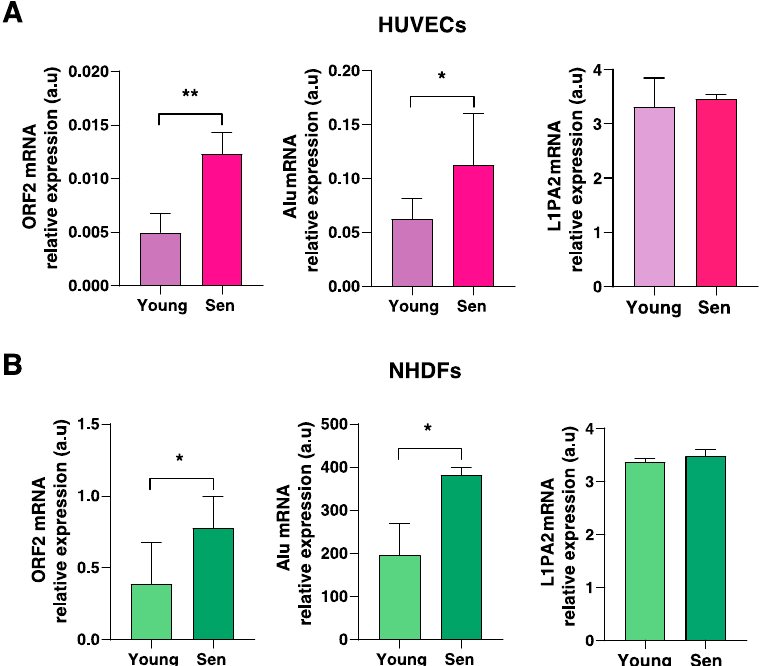
Figure 4. Relative expression of ORF2, Alu retrotransposable elements, and L1PA2 in ( A ) HUVEC and ( B ) NHDF cells. * p < 0.05; ** p < 0.01 for two-tailed paired t -test.